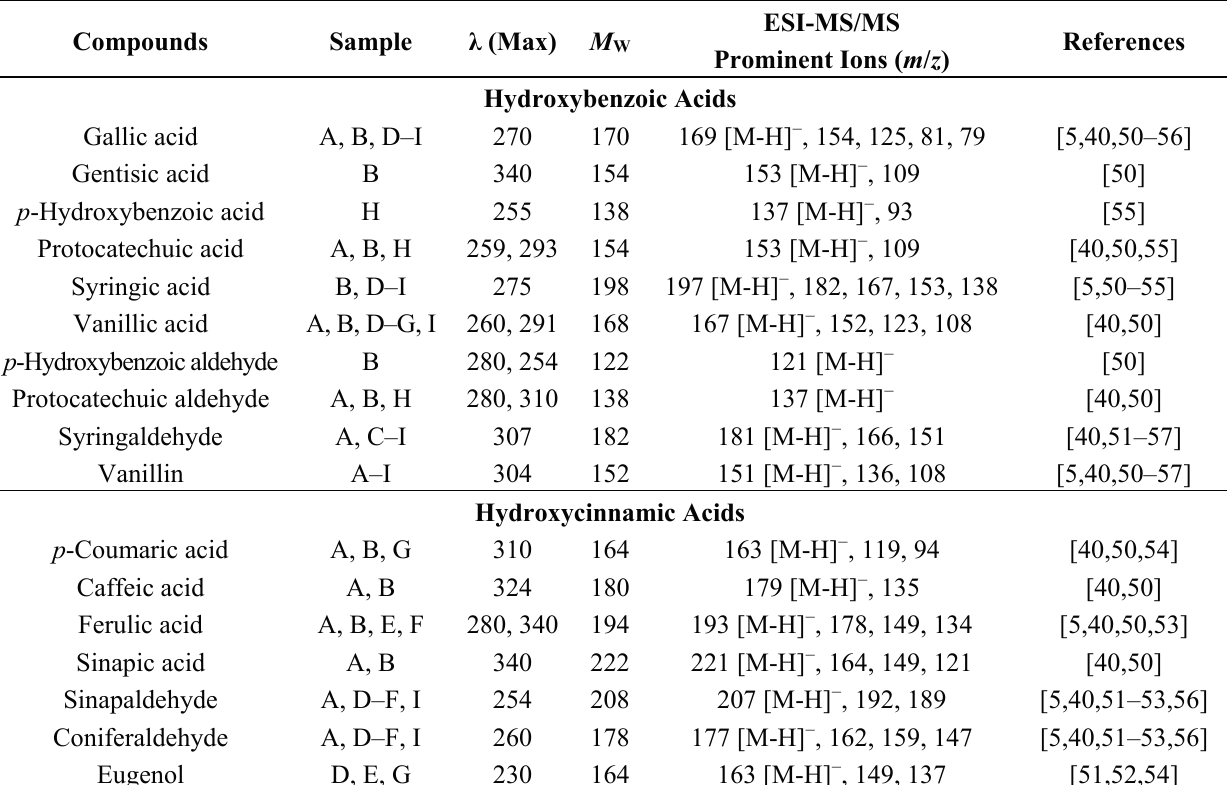
Figure 4. Chemical structures of phenolic acids in oak wood [47–49]. Table 3. Phenolic acids in oak